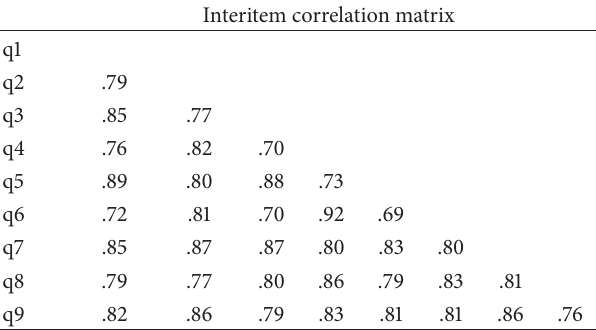
Table 2: Interitem correlation of PDRQ-9 Bangla.